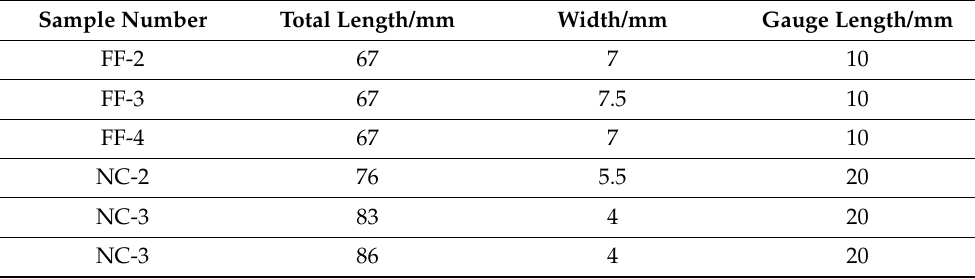
Table 3. The sample dimensions for different C/SiC